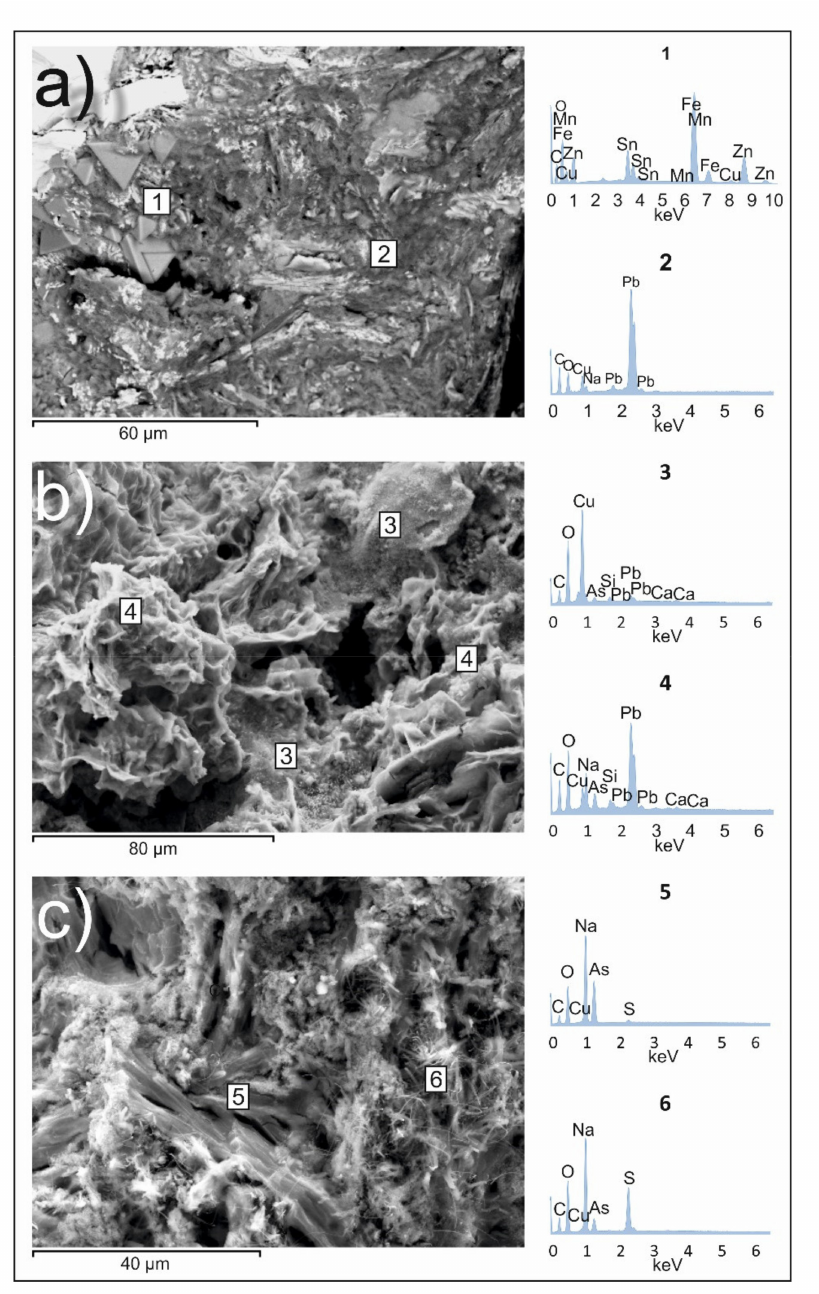
Figure 4. Scanning electron microscopy (SEM) images that were obtained by detecting the backscat- tered ( a ) and secondary ( b , c ) electrons. (1) Franklinite crystals; (2) vitreous matrix composed mainly of Na, Cu and Pb; (3) spertiniite aggregates; (4) NaPb 2 (CO 3 ) 2 (OH); (5) Na arsenate filaments; (6) thenardite